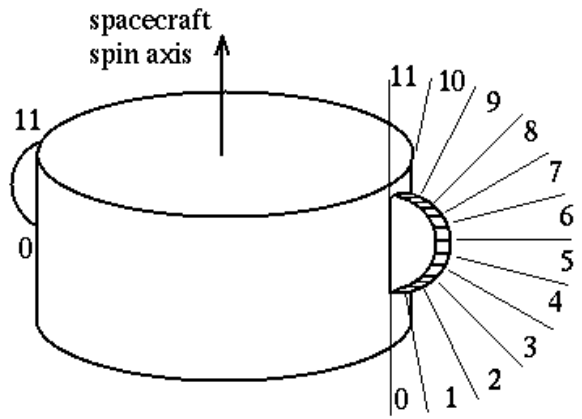
Fig. 1. PEACE anode numbers (equal to polar zone numbers). The spacecraft spin axis points a few degrees sunward of GSE south. There is a larger spacecraft surface in front of the field-of-view of anode 0 than of anode